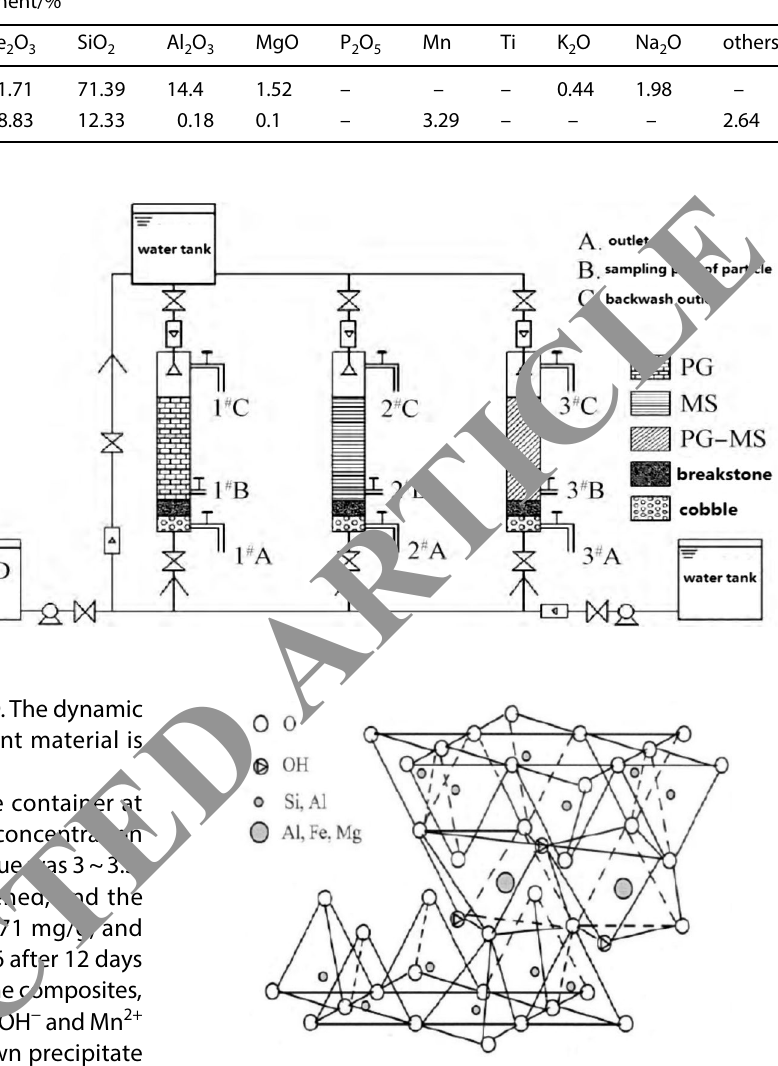
Fig. 2 Schematic diagram of crystal structure of